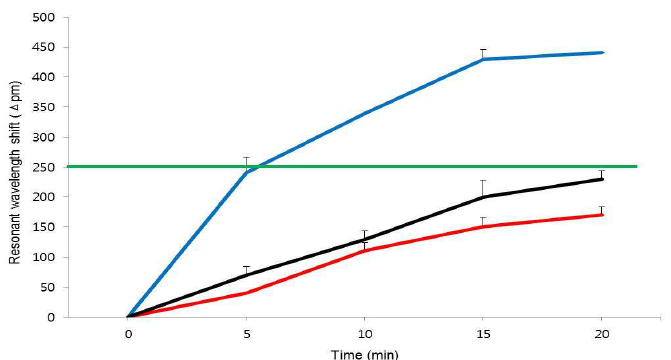
Figure 3. The identification resonant wavelength shift for the C. burnetii detection using a silicon microring resonator sensor. The blue line shows an acute Q fever specimen ( C. burnetii DNA) as a positive, and the red and dark lines indicate the other febrile disease specimen and healthy control (no infection) as negatives, respectively. The resonant wavelength shift for the detection of C. burnetii was shown within 20 min. The green line indicates a criterion for positive and negative determination in 20 min. The error bars indicate the standard deviation of the mean, based on at least three independent experiments.